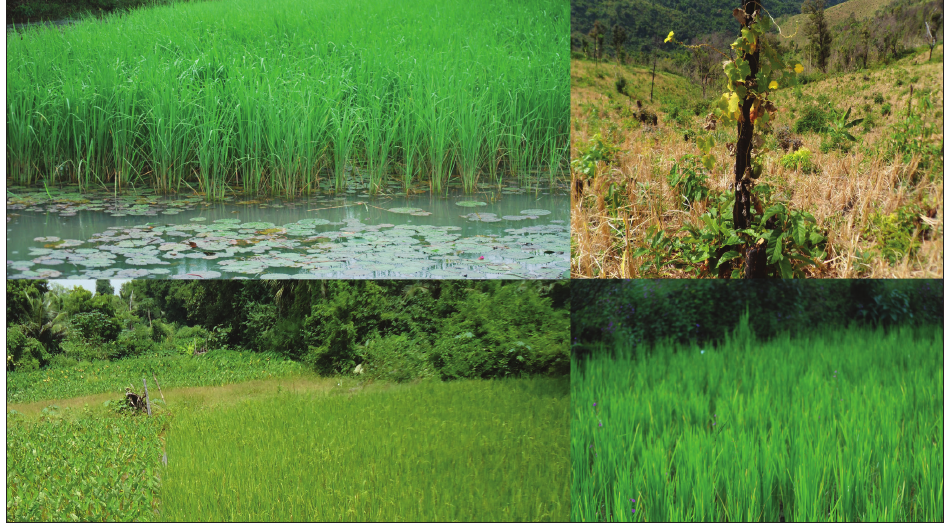
Figure 4: Examples of differing rice cultivation ecologies, clockwise from top left: deep water rice (Odisha, India); upland slash-and-burn rainfed (dry) rice (Laos); dry rainfed rice (Maharashtra, India); lowland irrigated/flooded wet rice (Odisha, India) (Photos DQF/